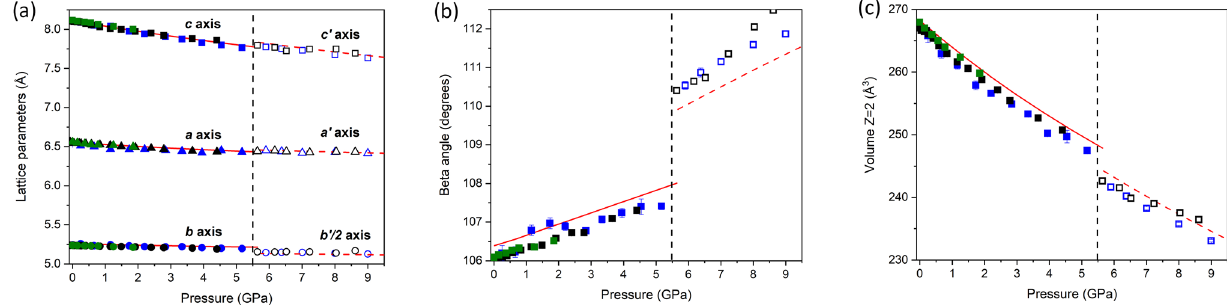
Figure 2. ( a ) Pressure dependence of the lattice parameters a (triangles) and c (squares) of low-pressure P 2 1 / m barytocalcite (solid symbols) and high-pressure Pm post-barytocalcite (empty symbols) BaCa(CO 3 ) 2 phases. Circles represent the b barytocalcite axis but half of the b ’ axis of post-baritocalcite. Blue symbols correspond to single-crystal data using a methanol:ethanol mixture as pressure transmitting medium, while black and green symbols correspond to two different powder runs using silicone oil as pressure medium. Solid and dashed red lines are fits to theoretical DFT data of the low- and high-pressure phases, respectively. The vertical dashed line indicates the transition pressure. ( b ) Evolution of the monoclinic β angle according to experiments and calculations. ( c ) Pressure dependence of the volume per 2 formula units of the two BaCa(CO 3 ) 2